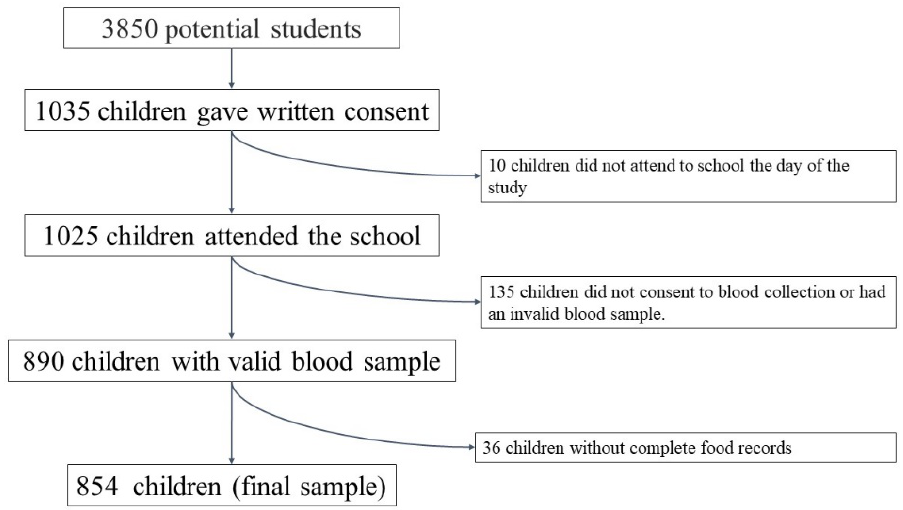
Figure 1. Flow chart of the selection process.